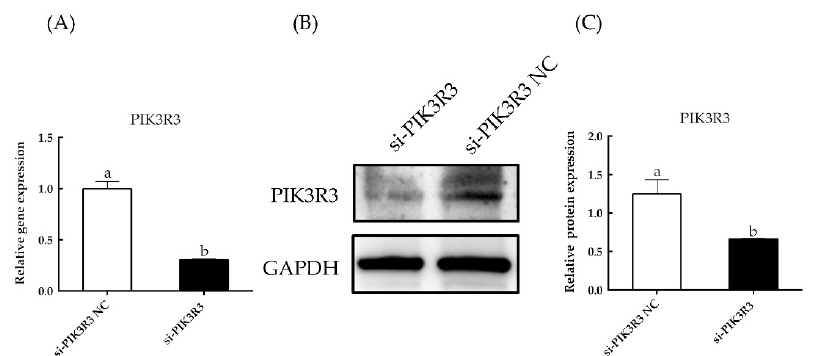
tively regulates the proliferation of HFSCs.